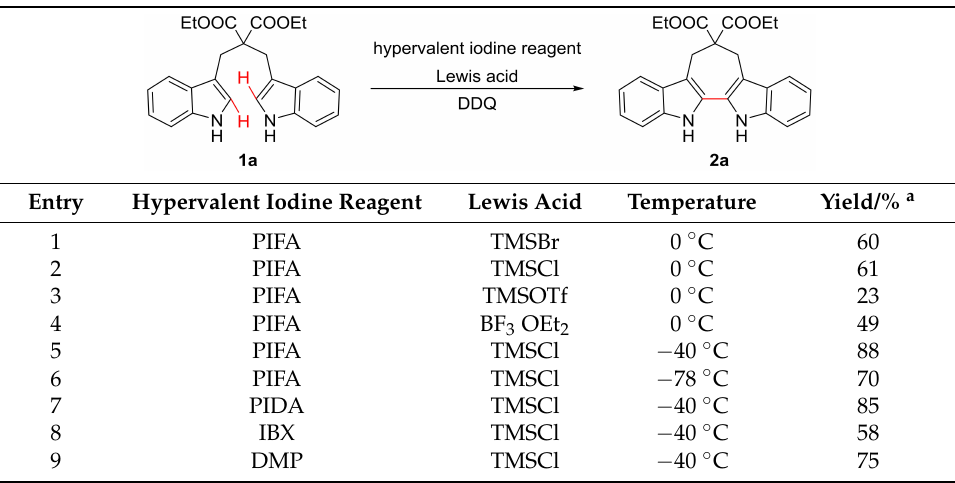
Table 2. Optimization of reaction